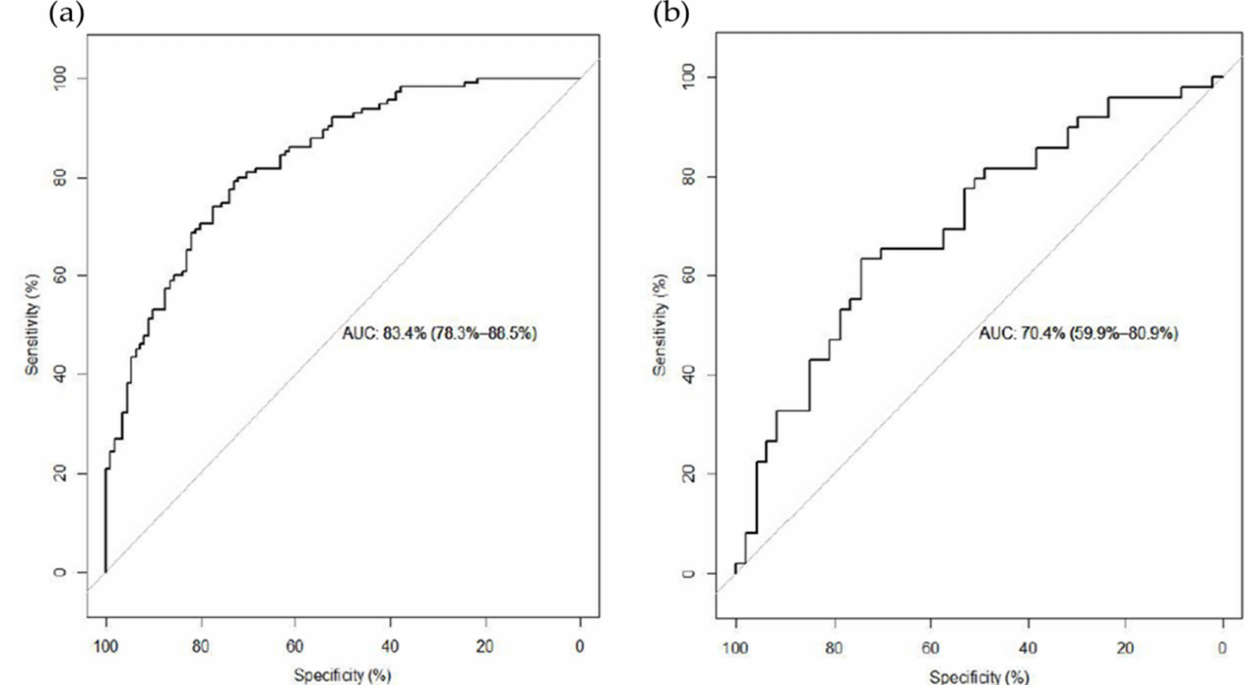
Figure 1. ( a ) Receiver operating characteristic curve of the combination of 10 differential metabolites between long-term red meat low consumers and high consumers in training set. ( b ) Receiver operating characteristic curve of the same metabolites in testing set for